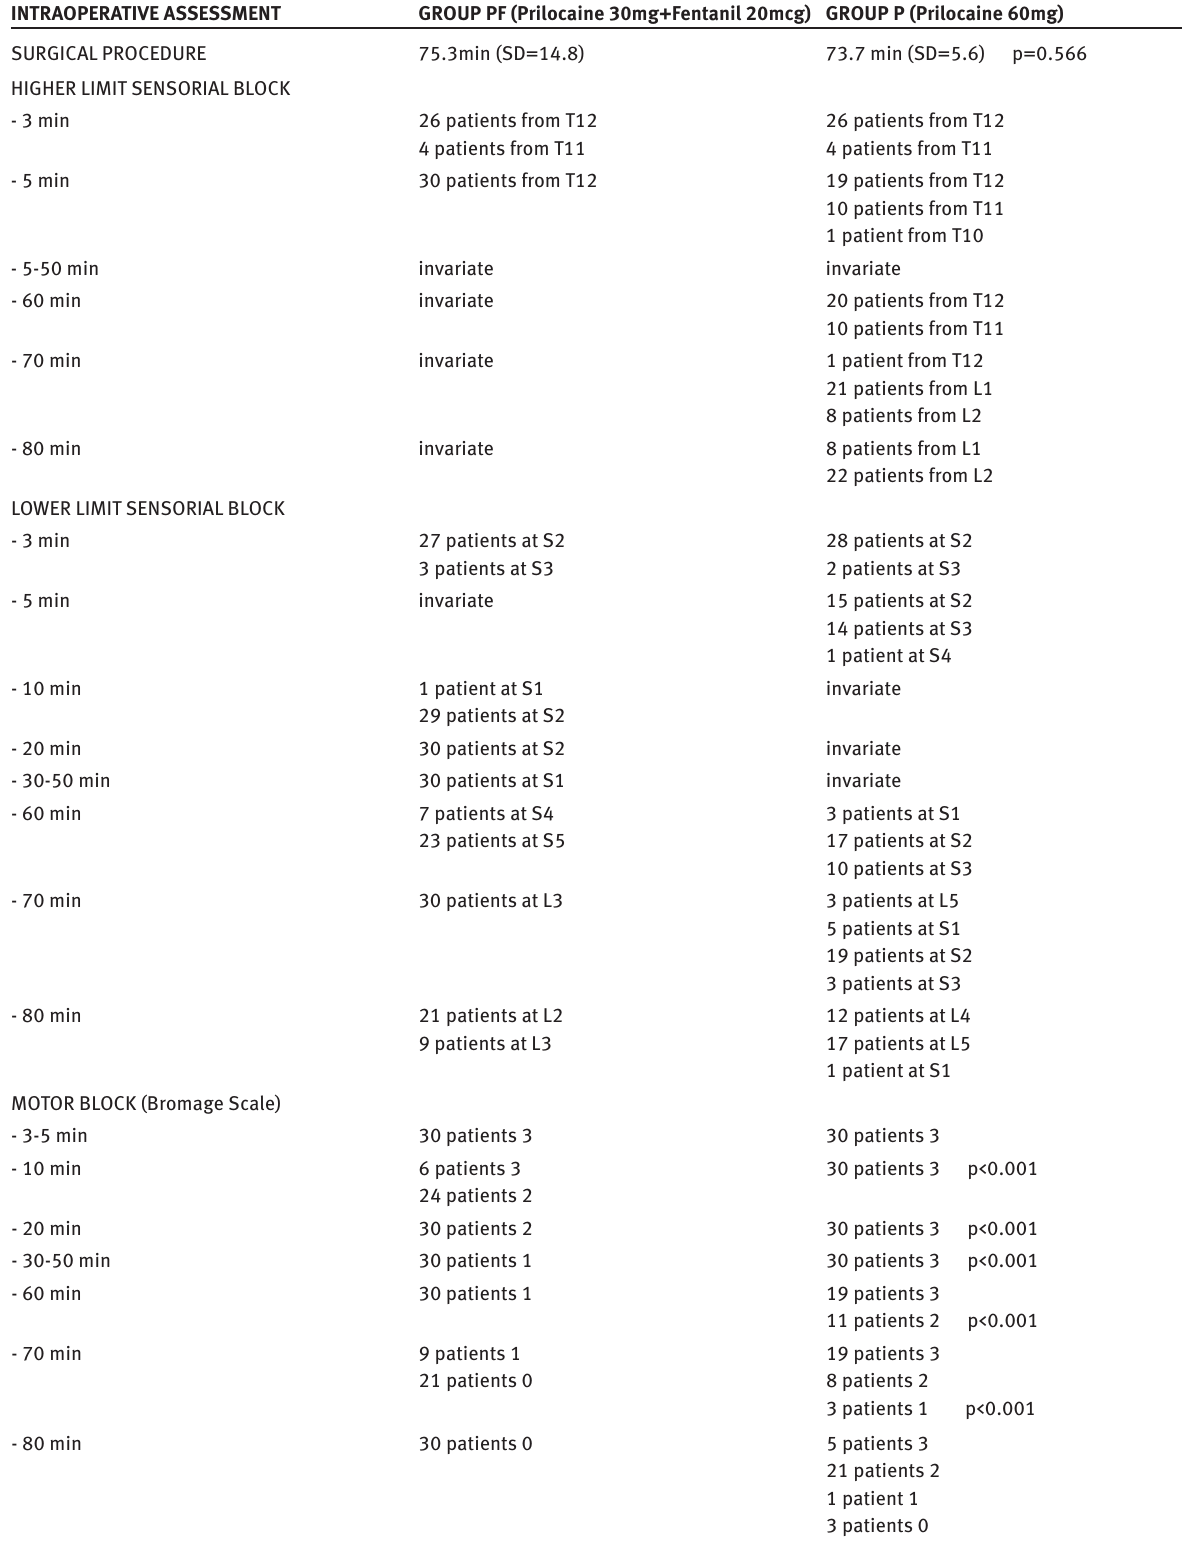
Table 1: Anesthetic blockage